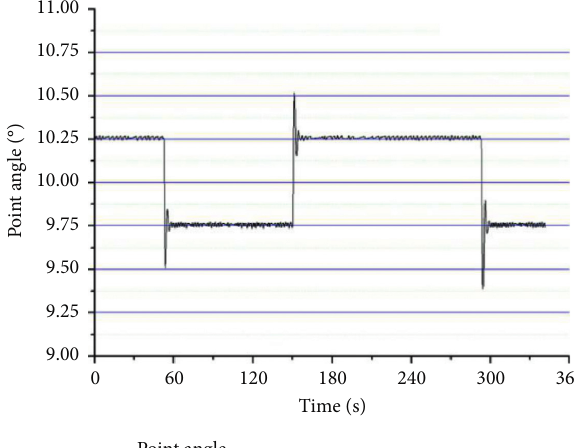
Figure 23: Tracking effect at 0.5 ° /s triangle wave input.